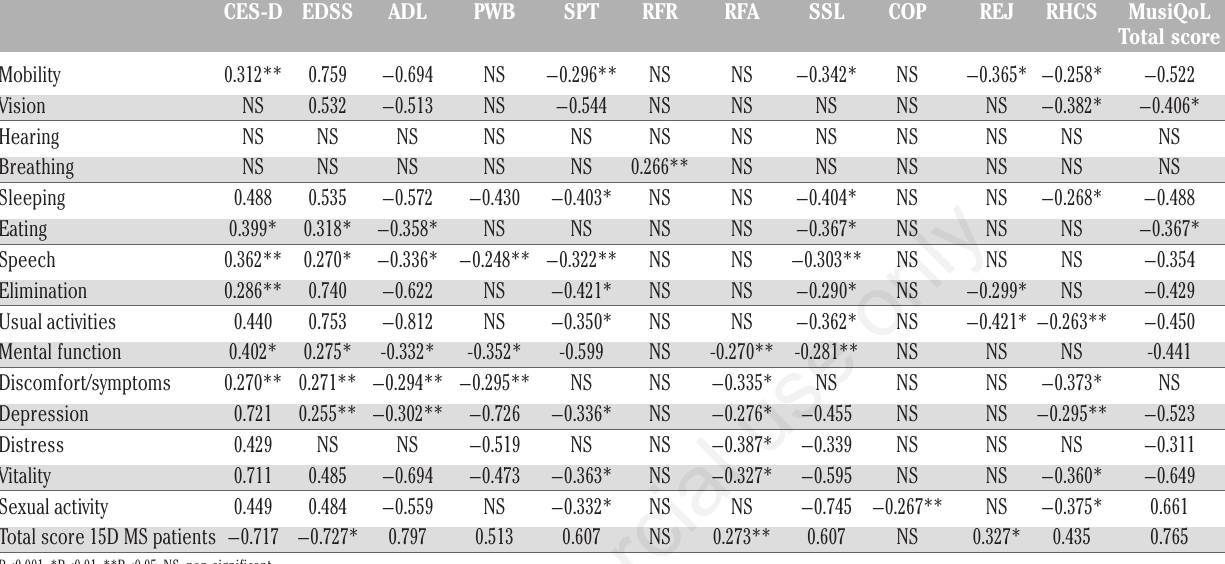
Table 4. Spearman’s correlation coefficients between 15D with CES-D, EDSS and MusiQoL.